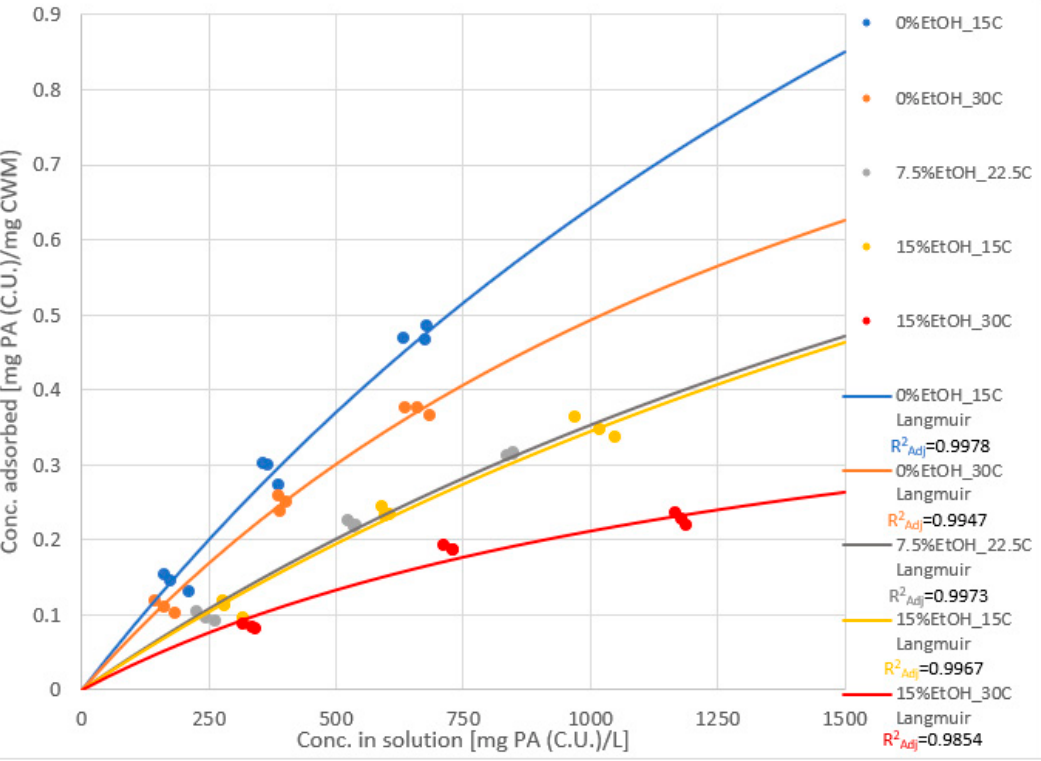
Figure 3. Adsorption isotherm of all experimental conditions, displayed as data points, with Langmuir models applied ( n = 9 for each isotherm).